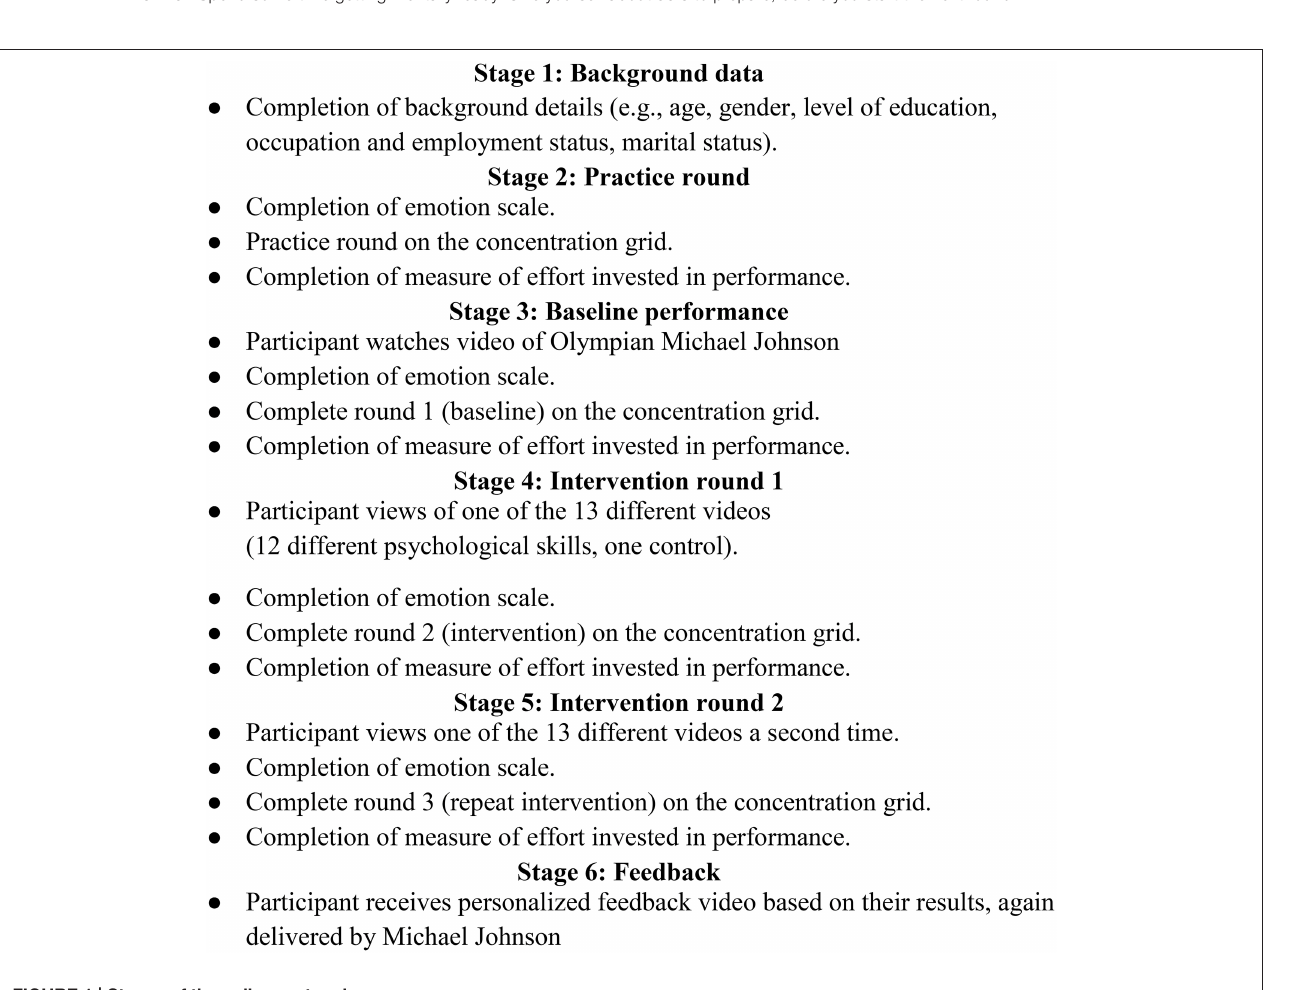
TABLE 1 | Intervention and examples of intervention scripts. Psychological skill: Process Outcome Arousal-control Instruction